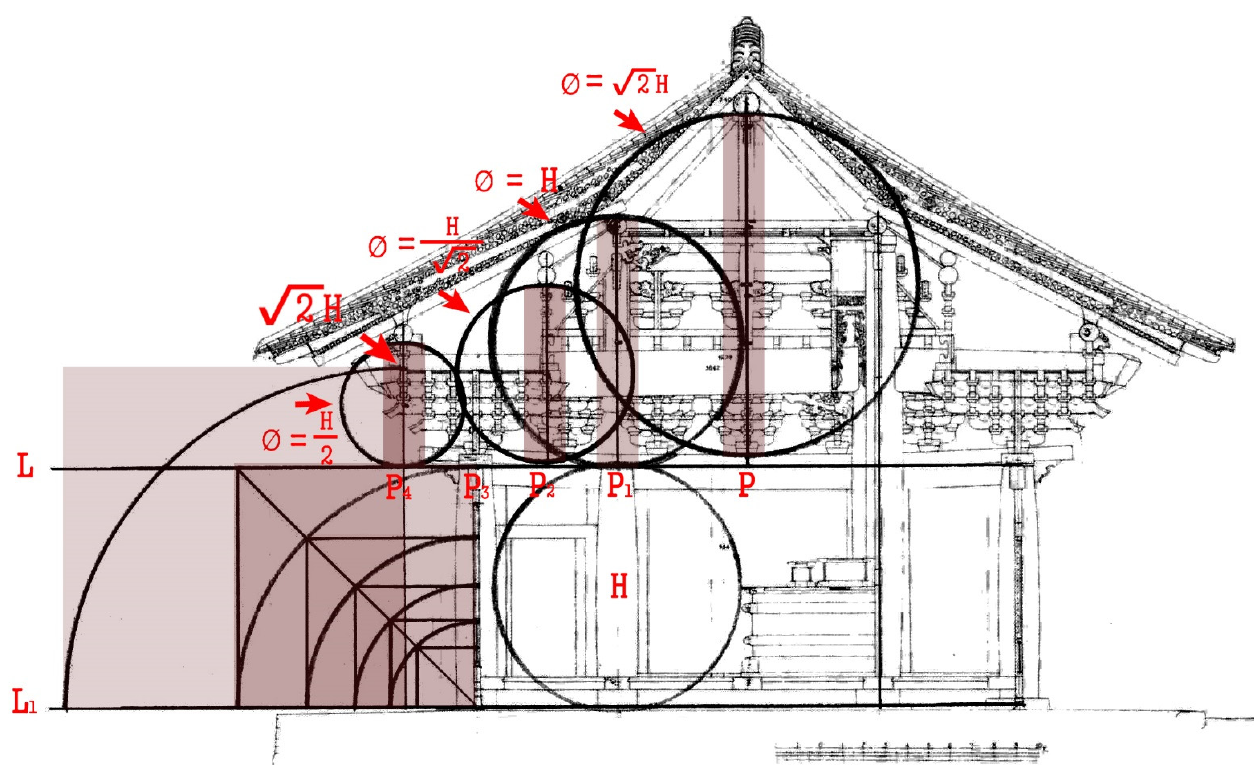
Figure 19. Bogwangjeon Hall of Simwonsa Monastery. Proportional analysis of the sectional elevation (H = eave column height, Ø = circle diameter), Adapted from CHA (NRICH 1998, p. 49).